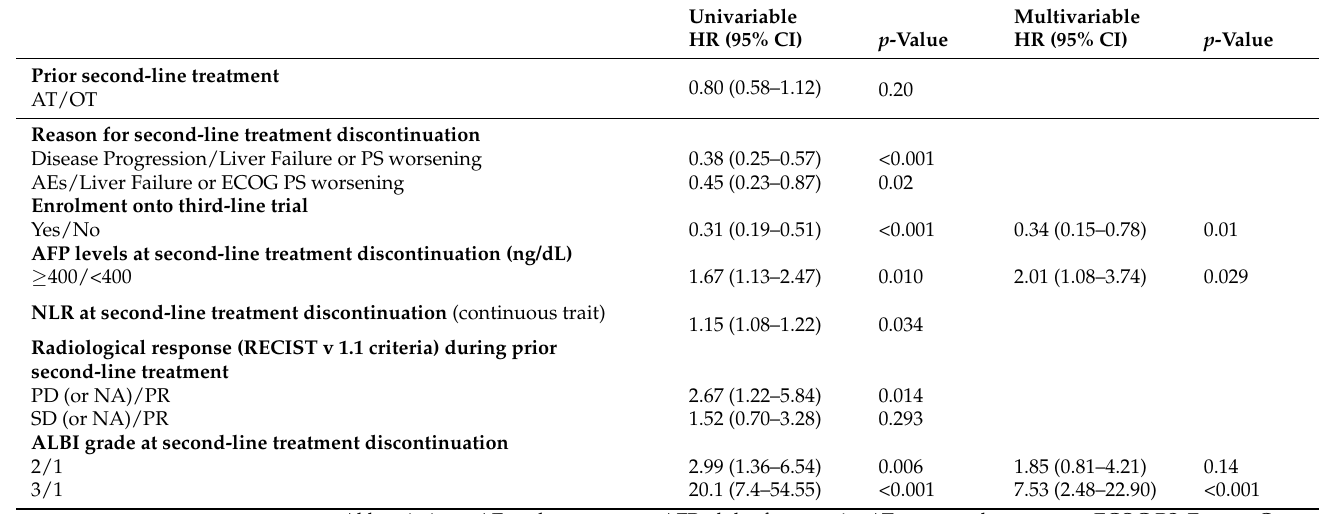
Table 6. Univariate and multivariate Cox analysis of factors affecting post-treatment